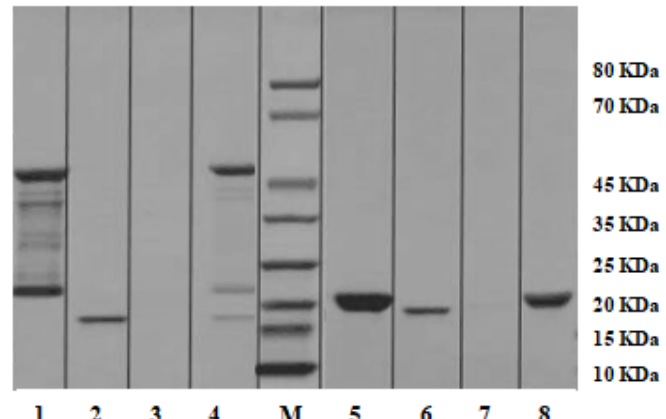
Figure 8. GST pull-down assays were conducted to examine the interactions between the ATG4B and ATG8 proteins. Lane M: protein molecular standard; lane 1: eluted protein from r MnATG4B incubated with r MnATG8 under reducing conditions; lane 2: purified r MnATG8 -His; lane 3: washing solution; lane 4: purified r MnATG4B -GST; lane 5: purified GST-tag protein; lane 6: purified r MnATG8 -His; lane 7: washing solution; lane 8: eluted protein from r MnATG8 incubated with the GST-tag under reducing conditions as a control.